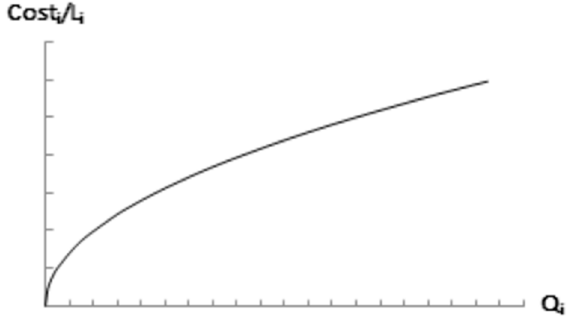
Figure 3. Schematic relation between pipe cost and flow.